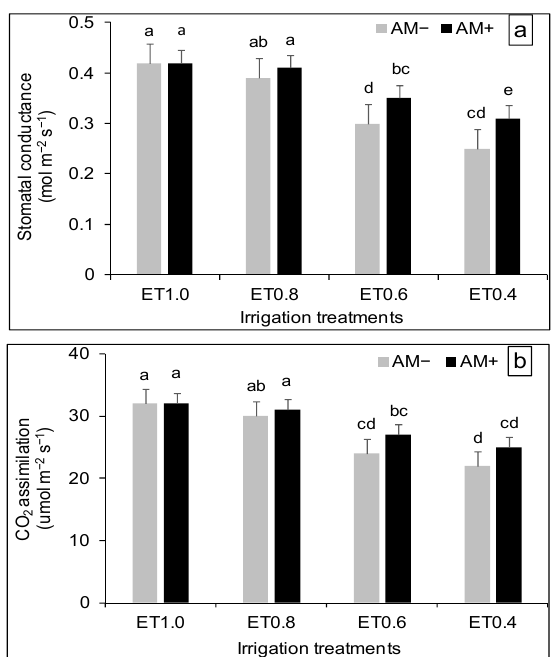
Figure 4. Changes of stomatal conductance ( a ), and CO 2 assimilation rate ( b ) at the flowering stage in eggplant subjected to varying water stress and AM inoculation. Data points are two years of pooled data of three replications.